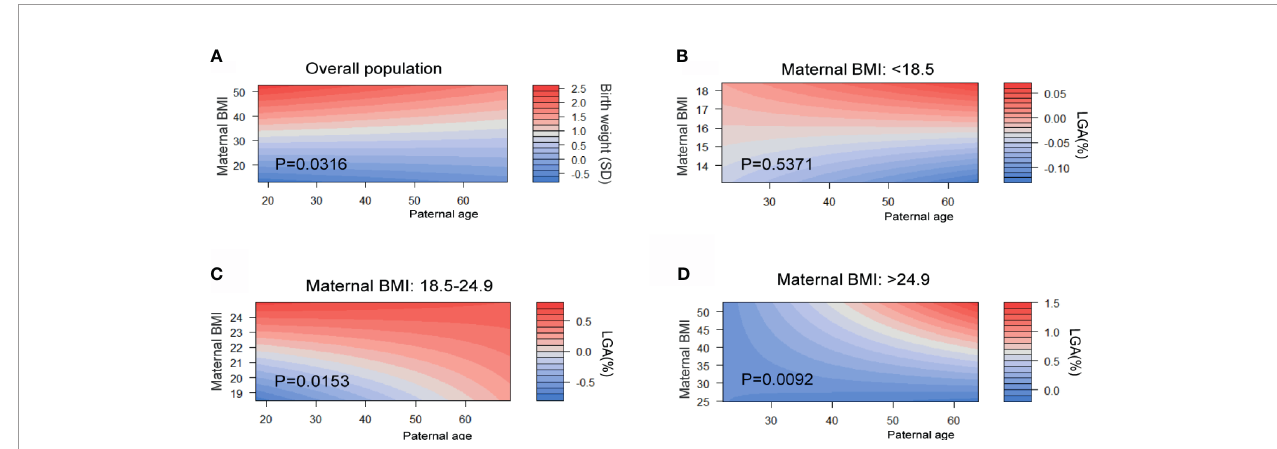
FIGURE 4 | Combined effects of maternal BMI in early pregnancy and paternal age on birth weight and LGA. Maternal BMI were categorized into three stages: underweight (BMI <18.5 kg/m 2 ), normal (BMI 18.5 to 24.9 kg/m 2 ), and overweight or obesity (OWO) (BMI ≥ 25 kg/m 2 ). Heat map ( fi lled contour plot) for the correlation of gestational age – adjusted birth weight (A) and paternal age in overall population (red indicates increased gestational age – adjusted birth weight; blue indicates decreased gestational age – adjusted birth weight). Heat map for the prevalence of LGA in three maternal BMI levels (B – D) (red indicates high risk, blue indicates low risk) according to their interaction with maternal BMI and paternal age are generated. Analyses were adjusted for maternal age, BMI, ethnicity, education level and marital